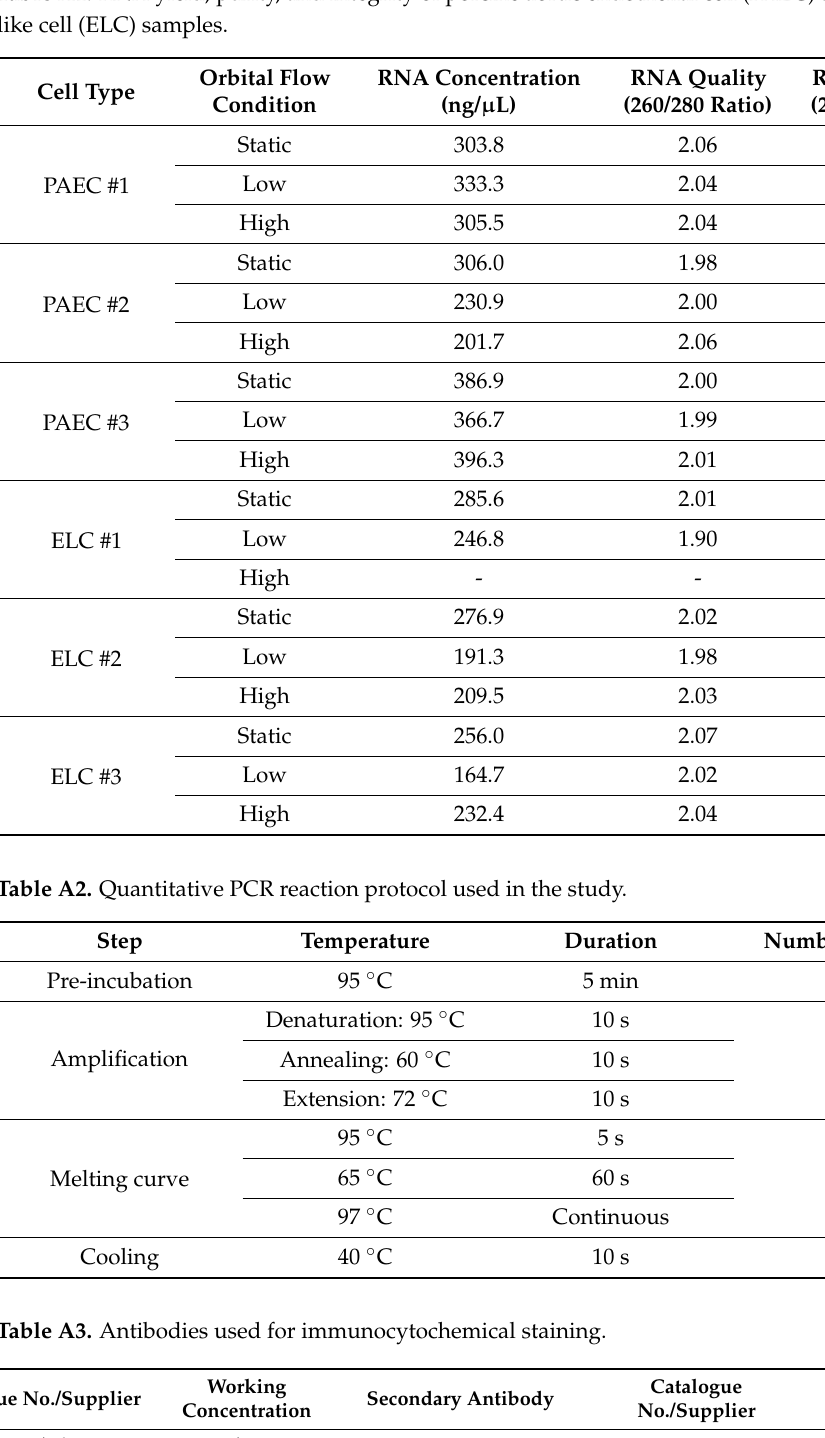
Table A1. RNA yield, purity, and integrity of porcine aortic endothelial cell (PAEC) and endothelial-